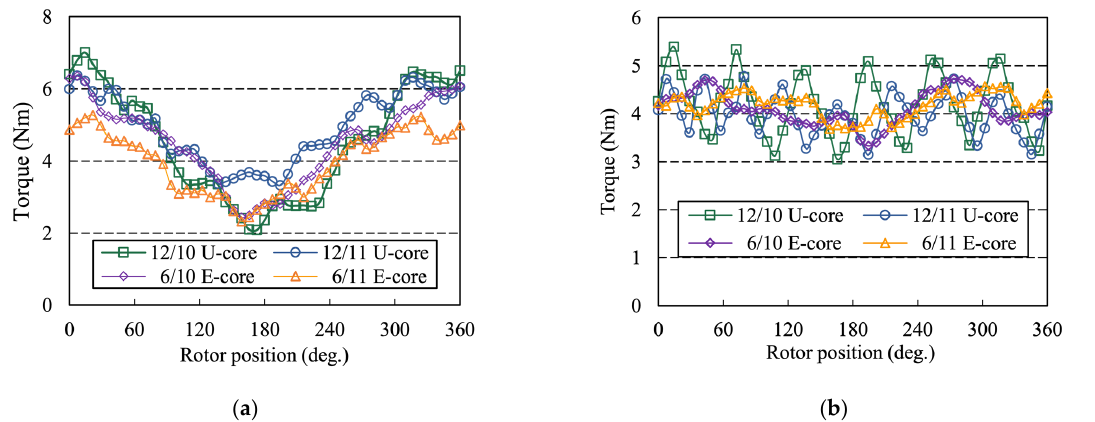
Figure 17. Electromagnetic torque under case I (phase A1, A2 open) and fault-tolerant control condition of four candidates. ( a ) Case I (phase A1, A2 open-circuit); ( b ) fault-tolerant control.